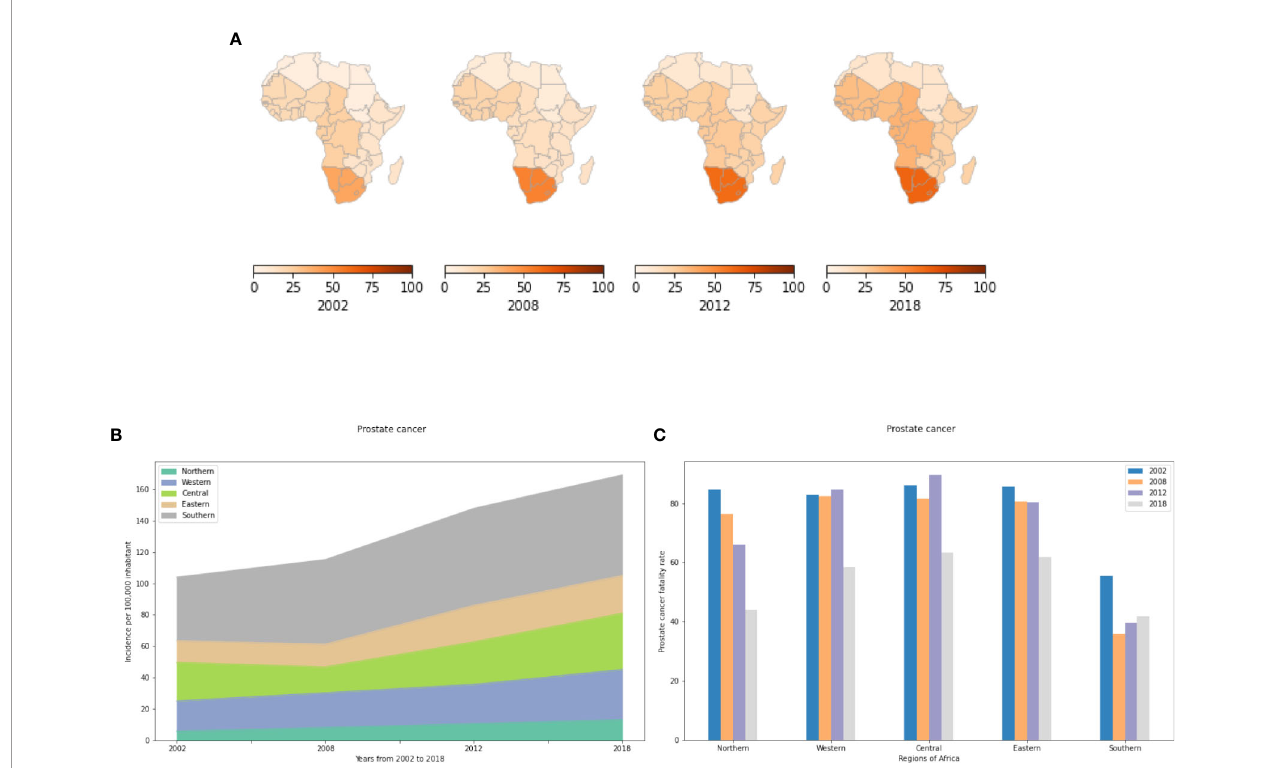
FIGURE 2 | Incidence and fatality rate for prostate cancer per 100,000 inhabitant from 2002 to 2018 in Africa. (A) Prostate cancer incidence rates in the different African regions per 100,000 inhabitant. (B) Incidence rates from 2002 to 2018. (C) Prostate cancer fatality rates (percent mortality per year of those af fl icted) in the different African